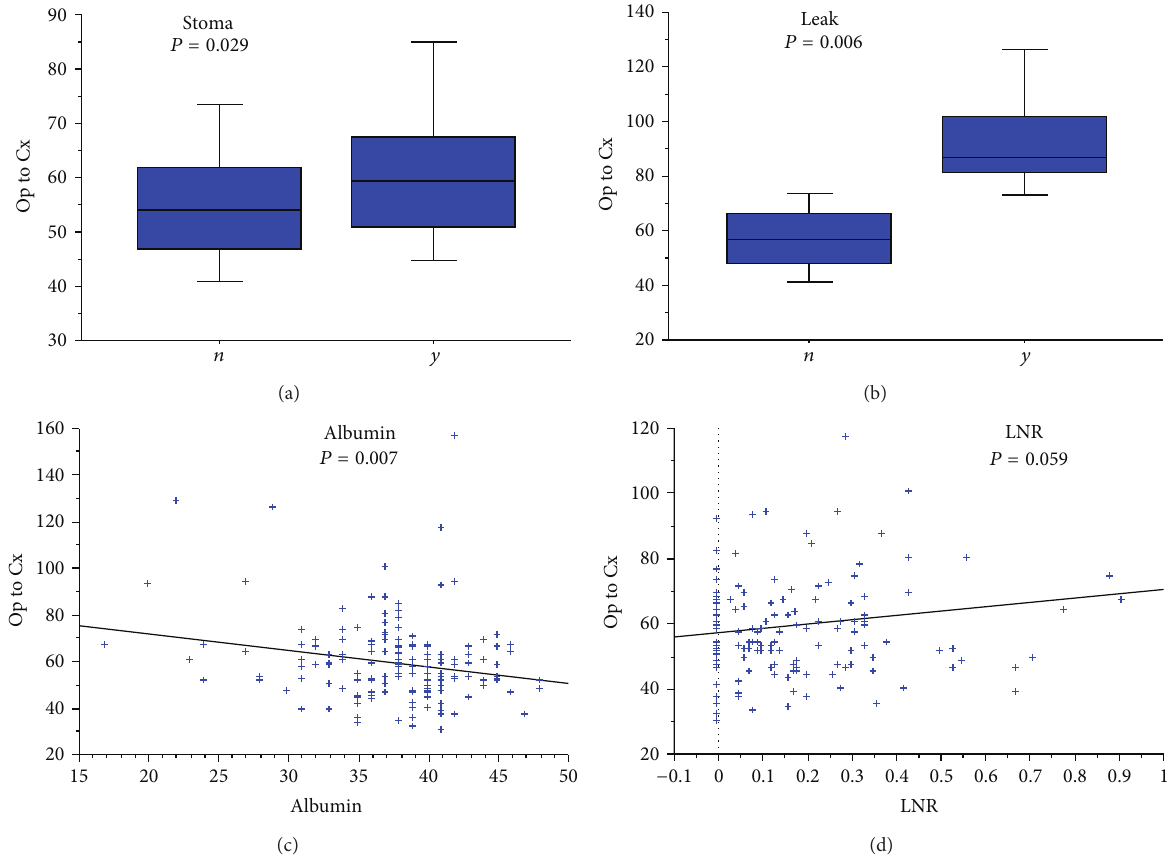
Figure 2: Relationship between requirement of stoma (a), anastomotic leak (b), preoperative serum albumin (c), and lymph node ratio (d) with time to adjuvant chemotherapy (categorical variables = Mann-Whitney; continuous variable = linear regression).